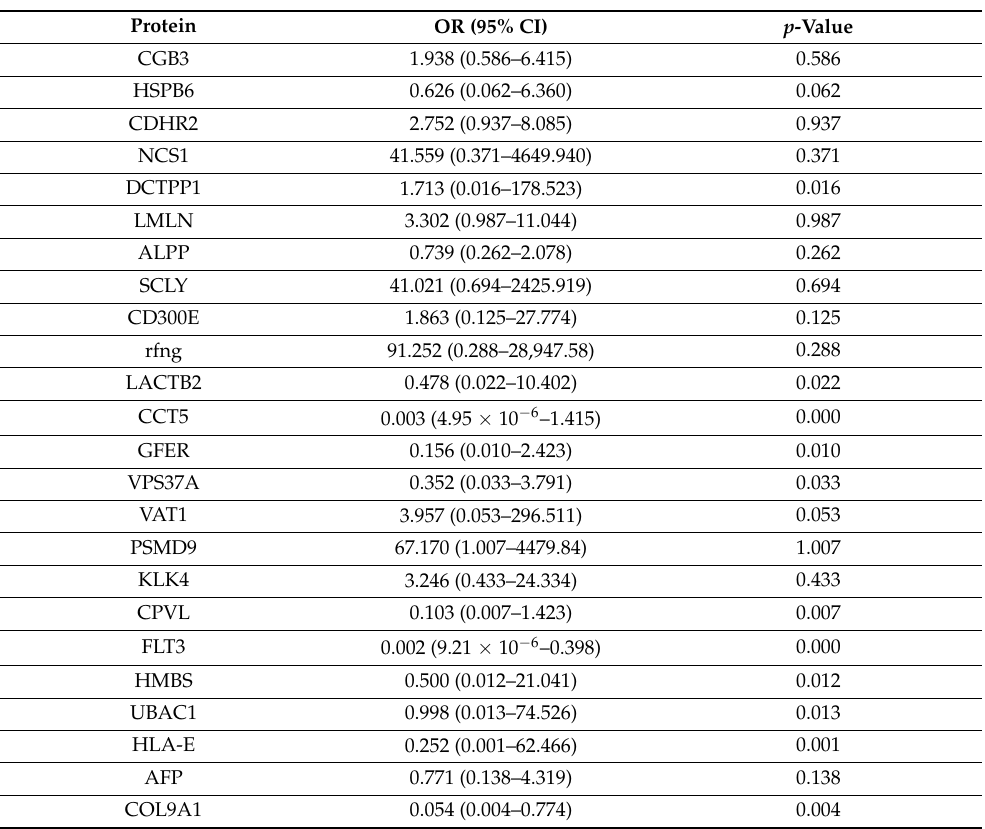
Table 6. Multivariate logistic regression model including all variables from the oncology panel with p < 0.02 at binary logistic